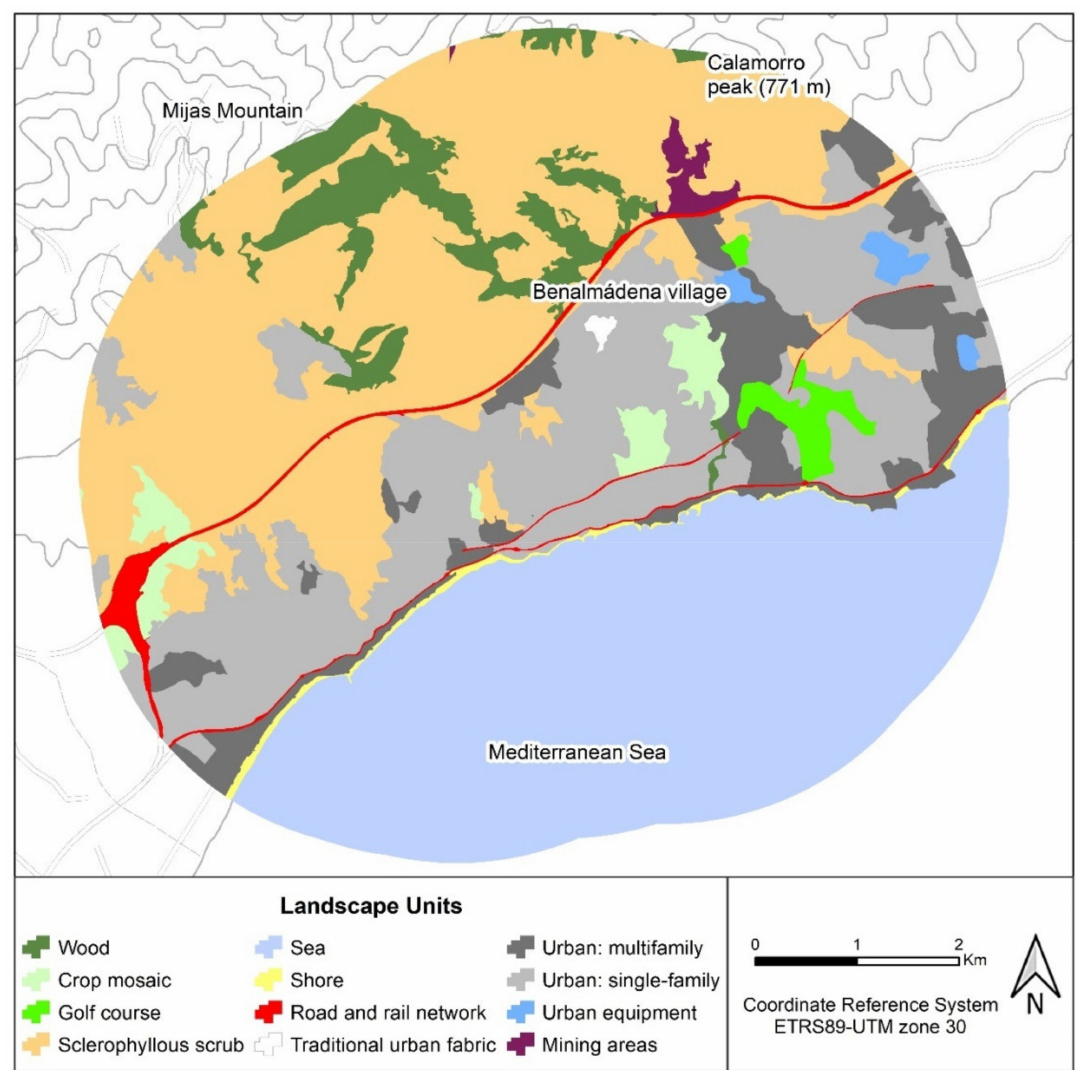
Figure 9. Landscape units of the study area (own